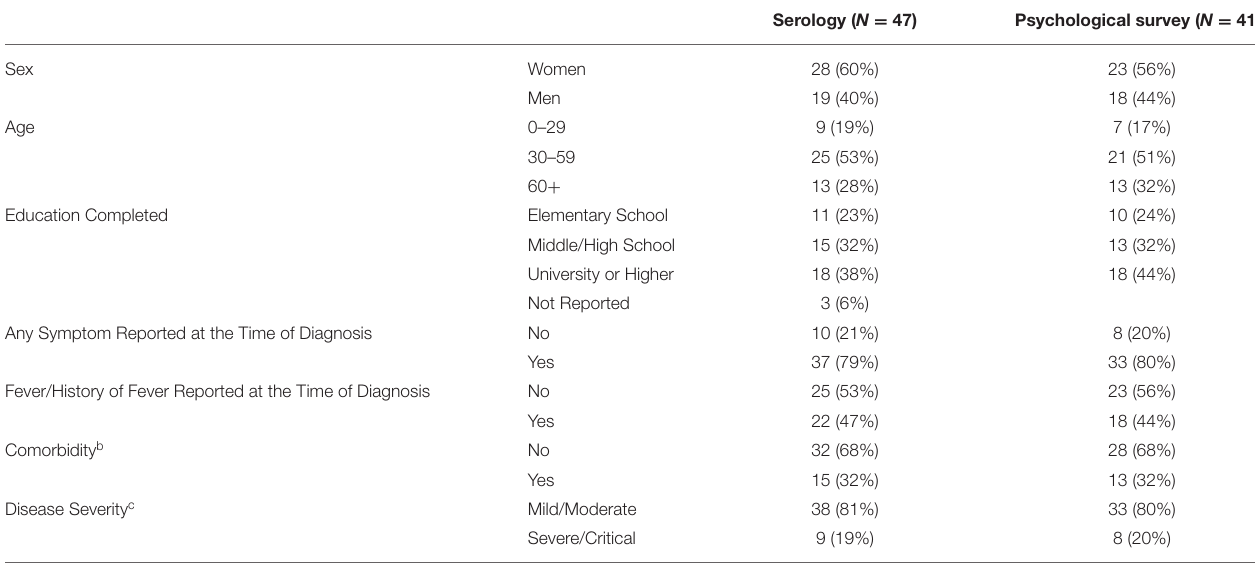
TABLE 1 | Baseline characteristics and disease severity by